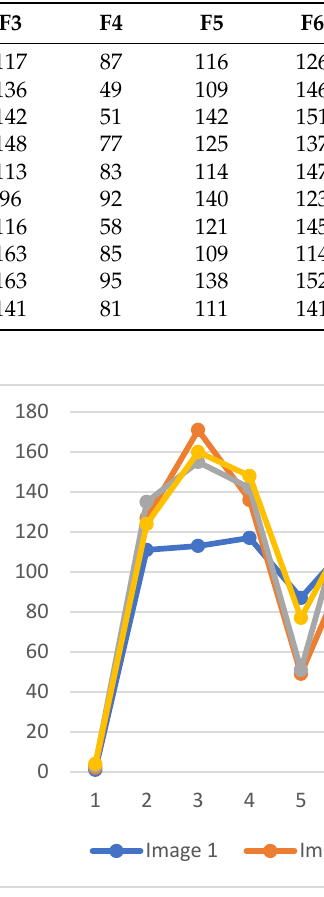
Figure 8. Comparison of the k-symbol FHF wavelet approximation coefficients of the sample images.